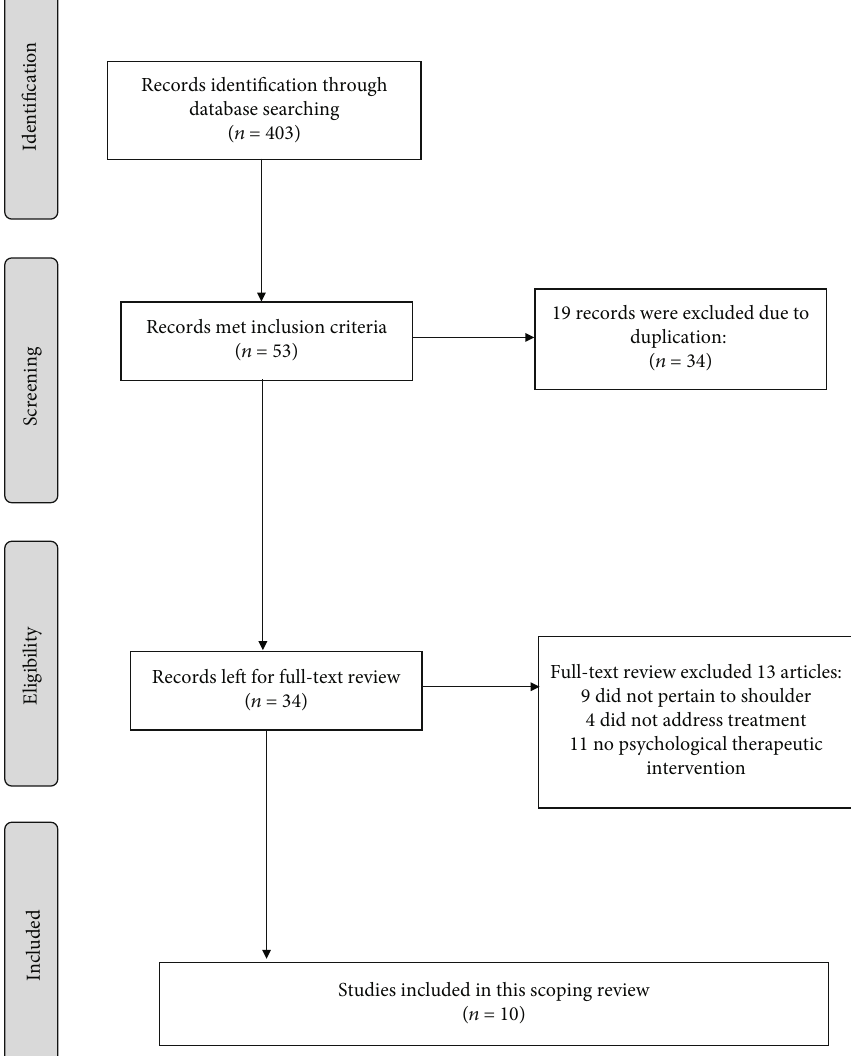
Figure 1: PRISMA fl ow chart of the selection of the studies for inclusion in the